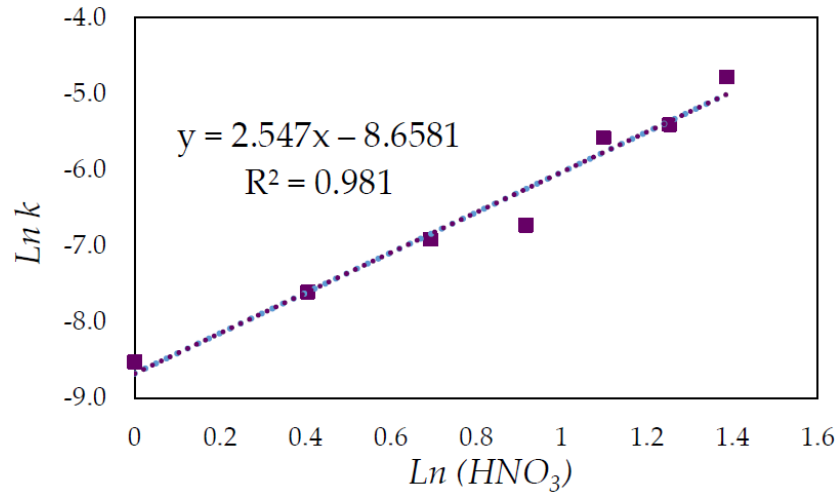
Figure 12. Plot of lnk as a function of ln ( HNO 3 ).